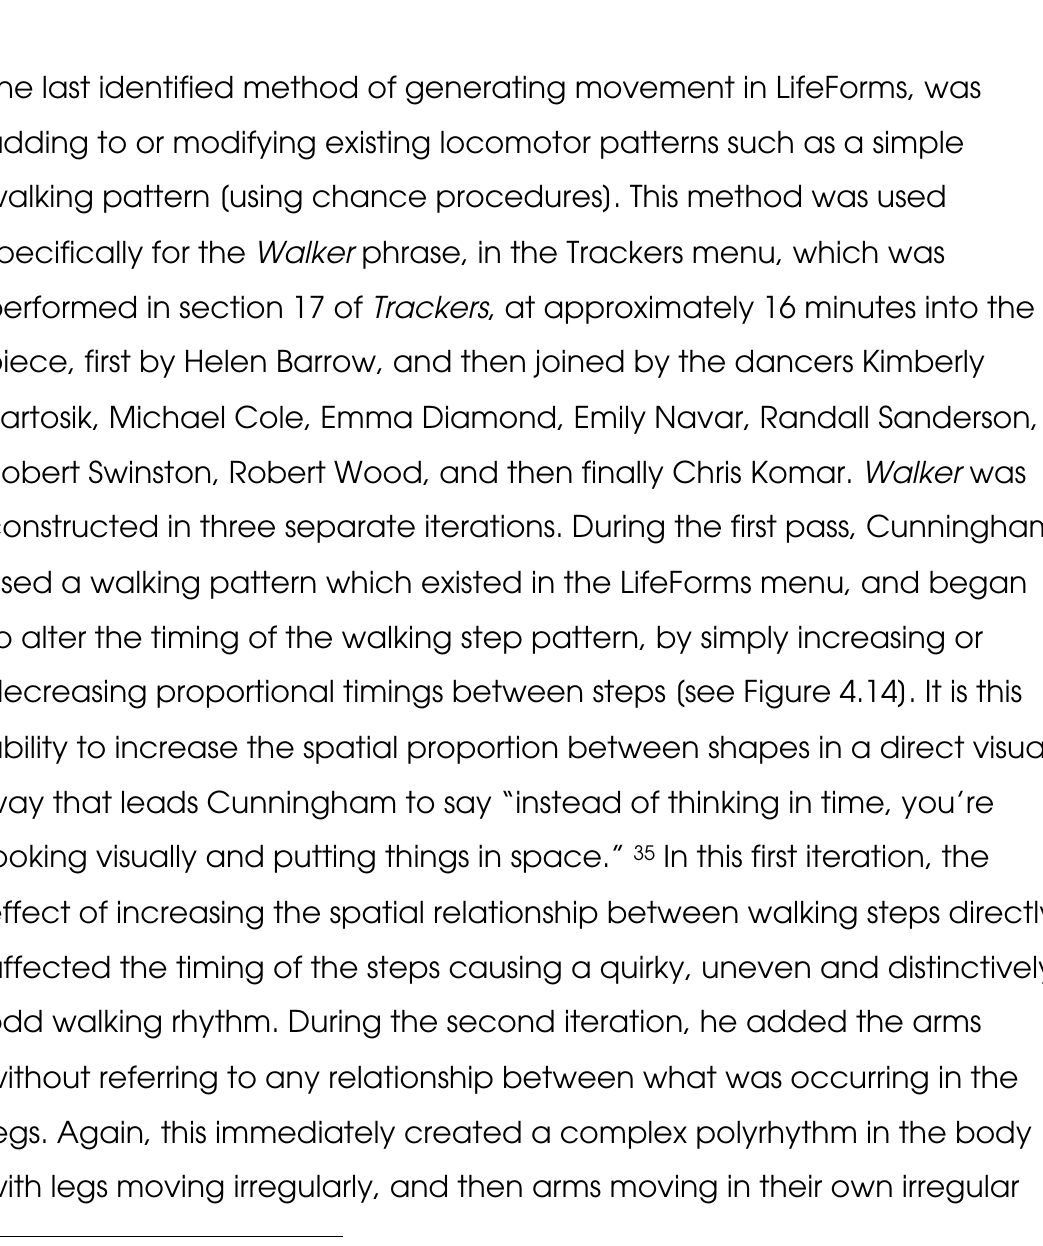
Figure 4.13. Apsaras 8 showing selection of limbs: shoulder, elbow, and